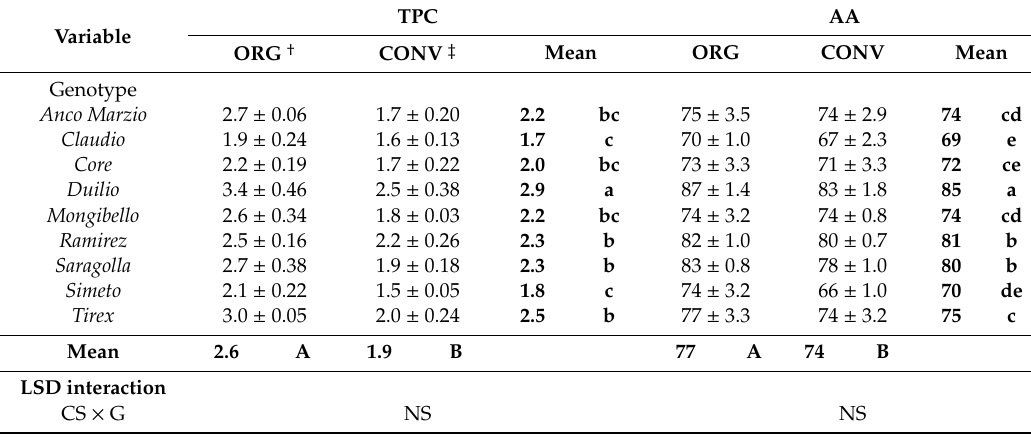
Table 5. Total polyphenols content (TPC; g kg − 1 dry matter) and antioxidant activity (AA; % inhibition of DPPH) as a ff ected by ‘cropping system (CS) × genotype (G)’ interaction. Di ff erent letters (a–e or A, B) within each main factor indicate significance di ff erences (LSD test, p ≤ 0.05). All data are expressed as mean ± standard